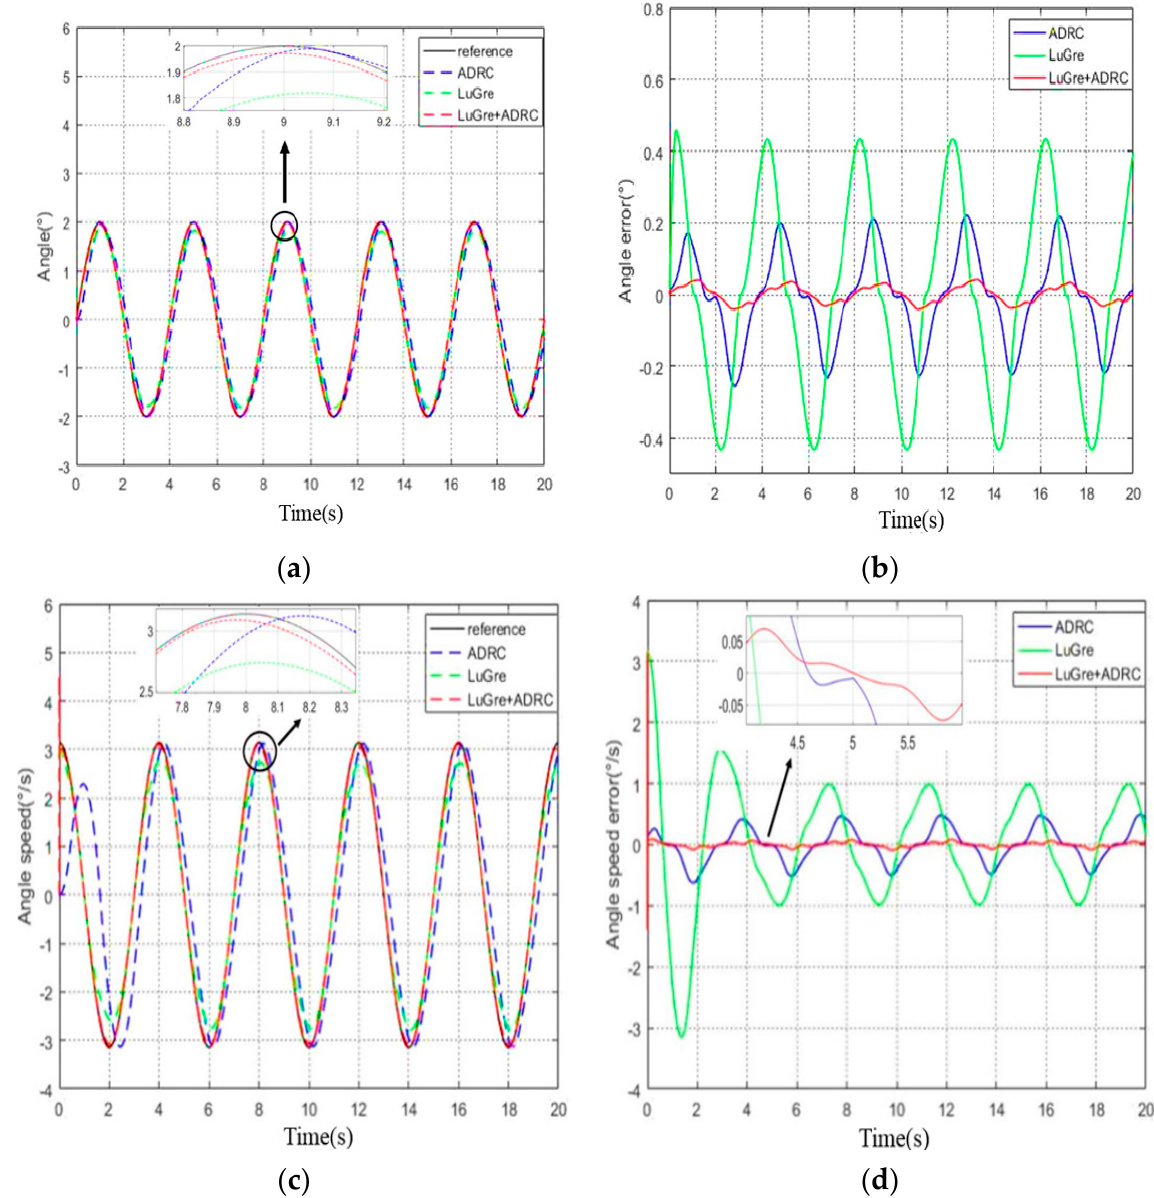
Figure 7. Sinusoidal trajectory tracking results. ( a ) Diagram of the angle tracking curve; ( b ) Diagram of the angle error curve; ( c ) Diagram of the angle speed tracking curve; ( d ) Diagram of the angle speed error curve. Table 2. Comparison of angle tracking error and angle speed error under sinusoidal input signal.